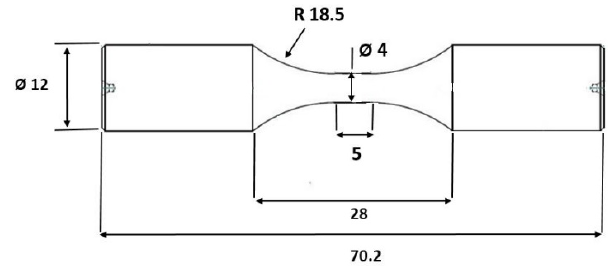
Figure 1. Specimen geometry used for experiments [28].